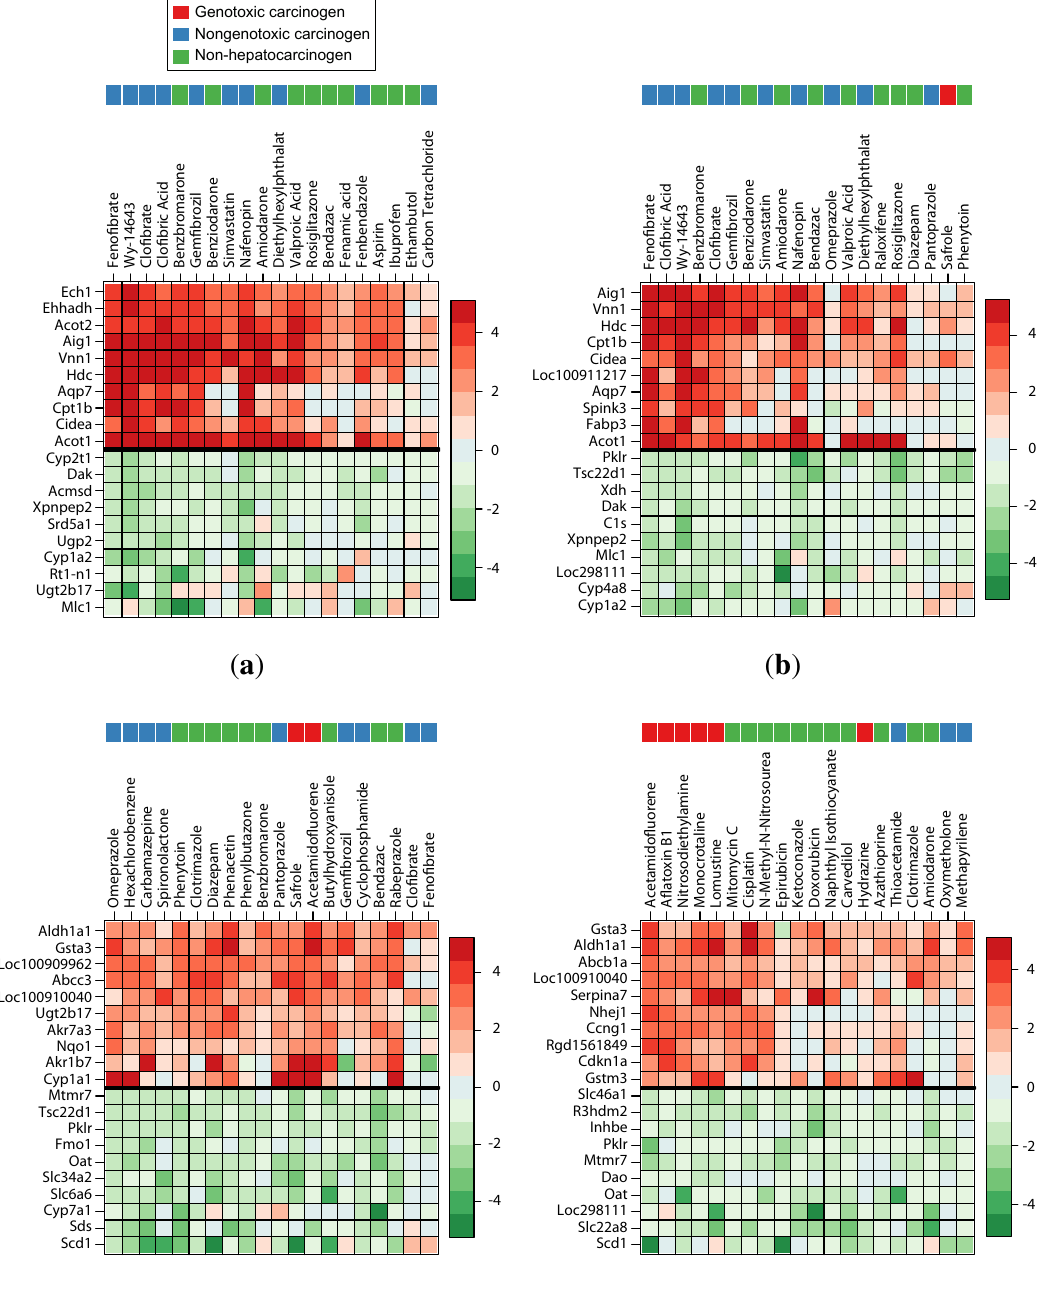
Figure 2. Gene expression heat maps of similar compounds. For selected test chemicals, we extracted the most similar chemicals included in either TG-GATEs or DrugMatrix. Each column corresponds to a chemical that was identified as similar. The chemicals are sorted from left to right by descending similarity score. The heat maps show the log 20 selected genes from the gene fingerprints of the test chemical. Genes above the black line are upregulated at least 1.5-fold in the test chemical, and genes below are downregulated, respectively. Genes were selected based on average expression in the identified chemicals. The color bar above the chemical name indicates the hepatocarcinogenicity annotation, and the legend is shown in ( a ). ( a ) Wy-14643 (NGC); ( b ) dehydroepiandrosterone (NGC); ( c ) piperonyl butoxide (NGC); ( d ) C.I Direct Black (GC).